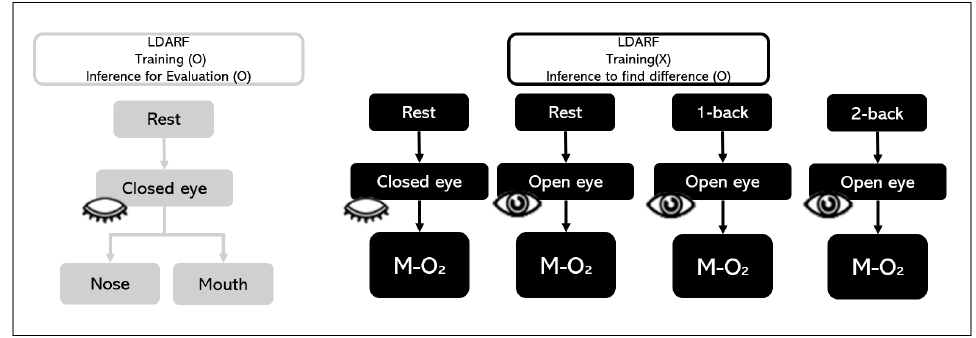
Figure 5. Electroencephalography (EEG) training dataset and EEG test dataset.